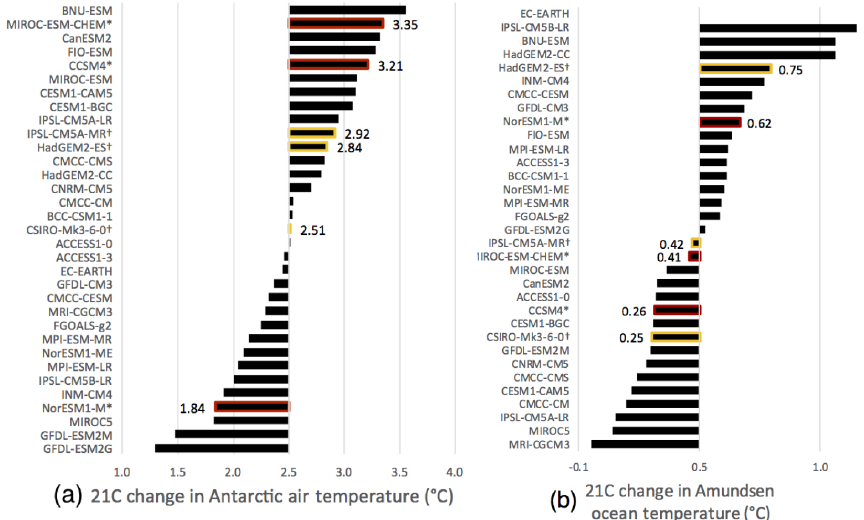
Figure 3. Projected RCP8.5 warming for each CMIP5 model in the Antarctic region. (a) Change in 850hPa air temperature over the Southern Ocean between 1980–2000 and 2080–2100. (b) Change in ocean temperature in the Amundsen region between 1980–2000 and 2080–2100. Models selected in the top three (top six) ensemble are highlighted in red